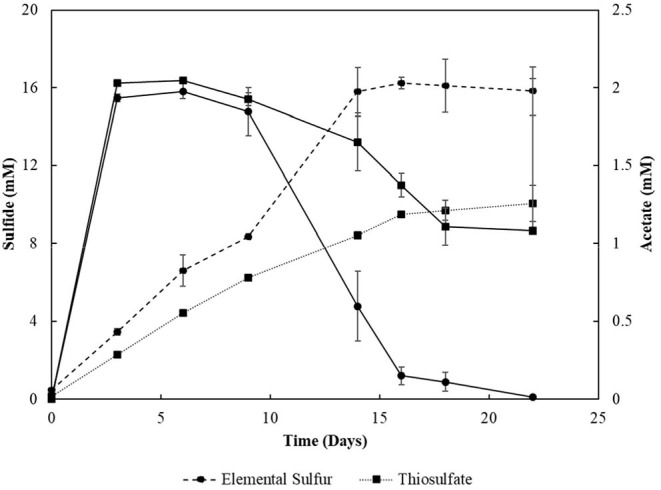
Sulfide production and acetate profile of the enrichments oxidizing oleate with elemental sulfur or thiosulfate as electron acceptors in sacrificial experiments. Dashed lines correlate to sulfide, and continuous lines correlate to acetate concentrations. Measurements of biological triplicates were averaged, and the standard deviation is shown.